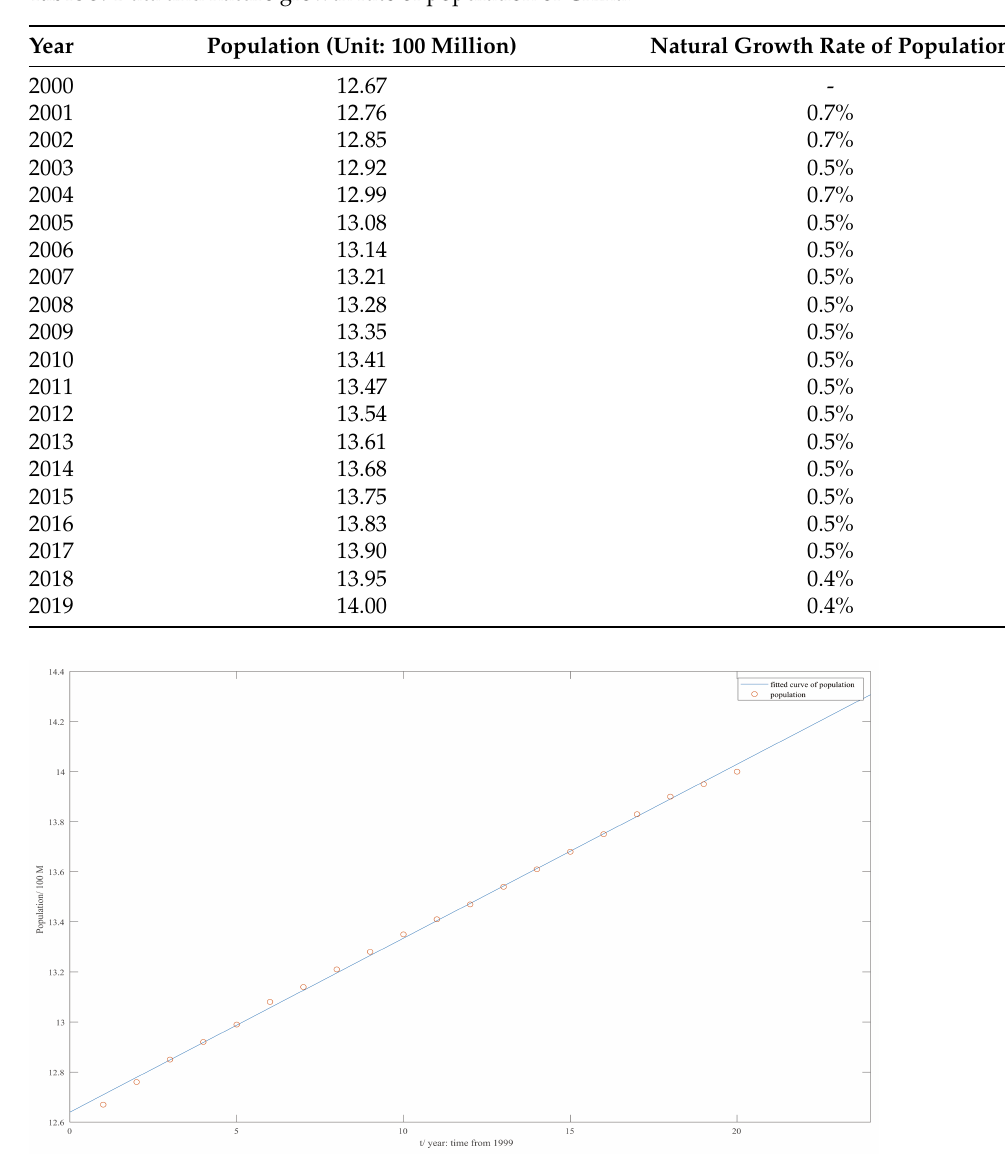
Table 3. Data and nature growth rate of population of China.